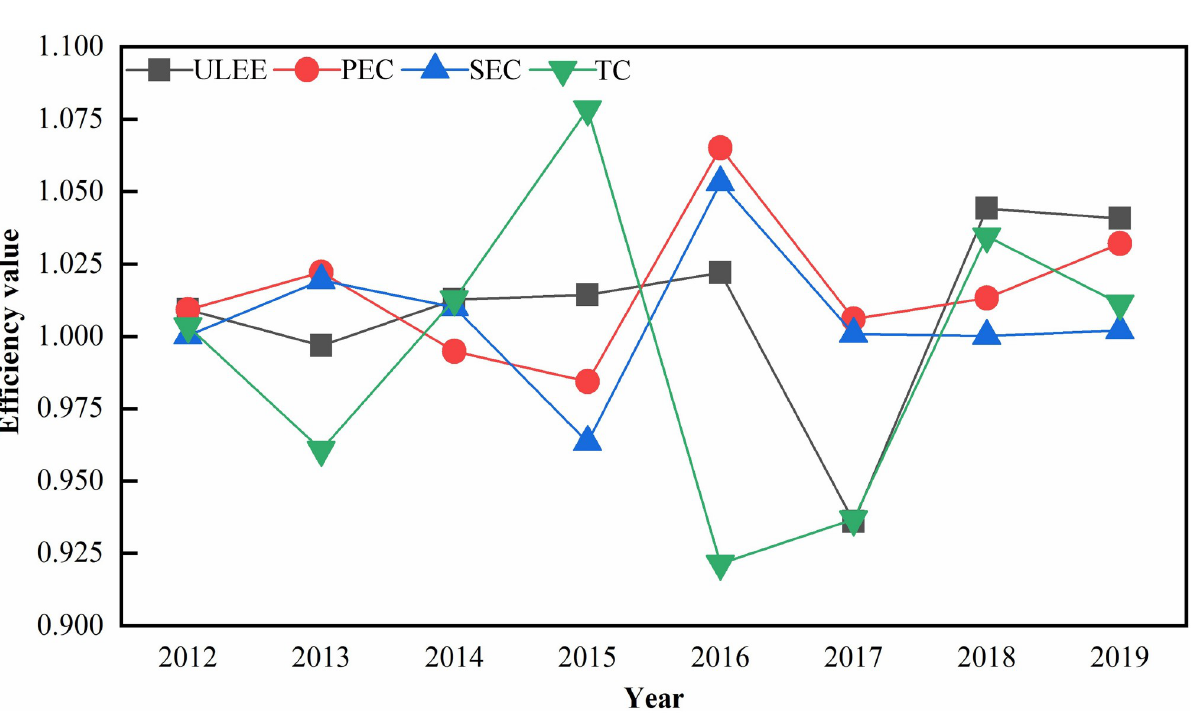
Fig 1. Trend of the